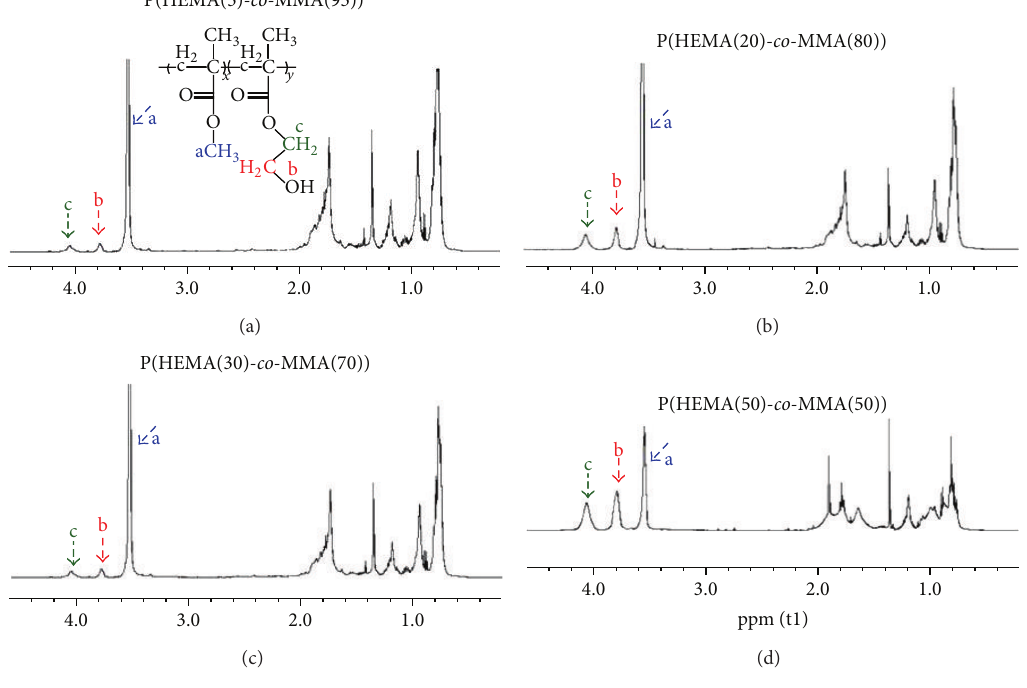
Figure 4: 1 H-NMR spectra of P(HEMA- co -MMA) copolymers ( 1a–1d ).